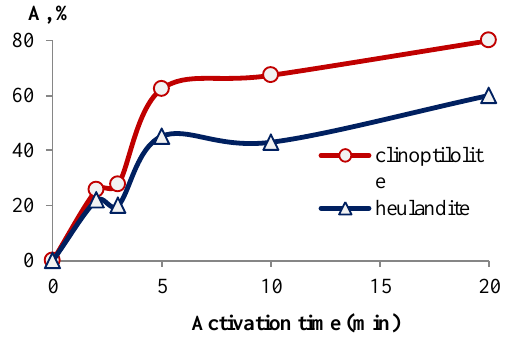
Fig.2. Influence of activation time in